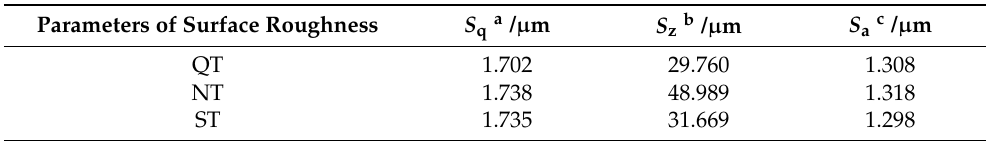
Table 1. Surface roughness parameters of the worn surface.